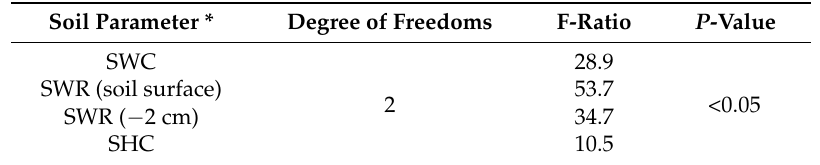
Table 3. Results of ANOVA applied to land uses (Abandoned Farmland; Intensive Agriculture; Forest) for soil water content (SWC), repellency (SWR) and hydraulic conductivity (SHC) in the study area (Villamalea, Castilla La Mancha, SE Spain).